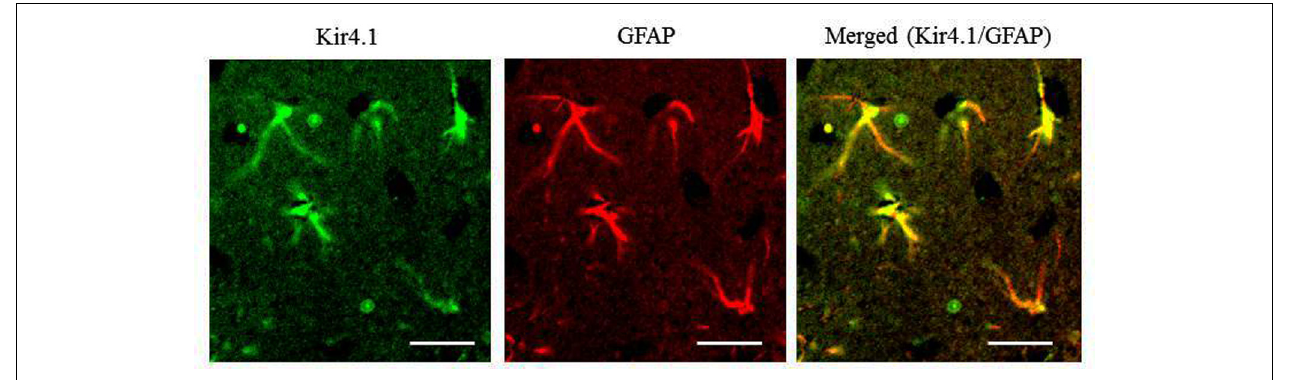
(Sigma-Aldrich) to probe Kir4.1 and GFAP, respectively. Immunofluorescence images were obtained with a confocal laser scanning microscope. Scale bar: 50 μ m. All the Kir4.1-immunoreactivity (IR)-positive cells with the stellate-shape were double-stained with anti-GFAP antibody (yellow in a merged picture). Kir4.1-IR was occasionally found in a few round-shaped cells with no GFAP-IR [also negative to a neuronal marker, neuronal nuclear antigen (NeuN)], which were omitted from the